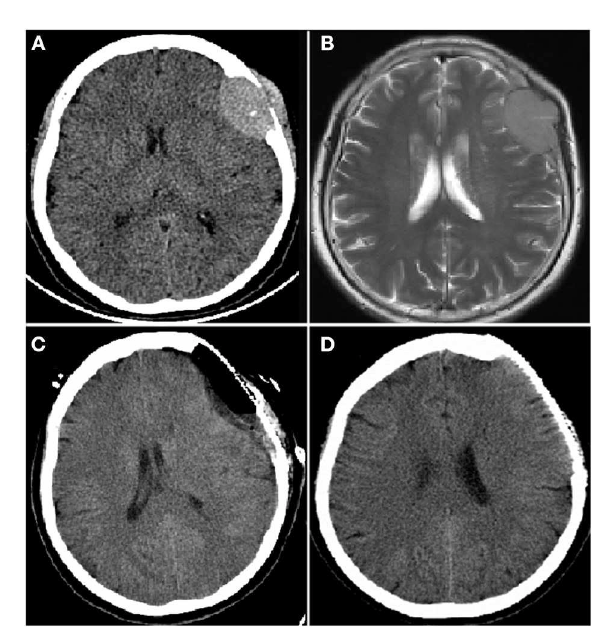
FIGURE2 Computer tomography (CT) and magnetic resonance imaging (MRI) brain images from a female patient present with left frontal mass. CT brain image (A) and enhanced MRI brain image (B) at diagnosis showed a mass of 3.2 × 4.8cm in left frontal lobe; CT brain image after resection of left frontal lobe mass, the mass disappeared (C) ; CT brain image before autologous hematopoietic stem cell transplantation (auto-HSCT), no mass in left frontal lobe (D) .